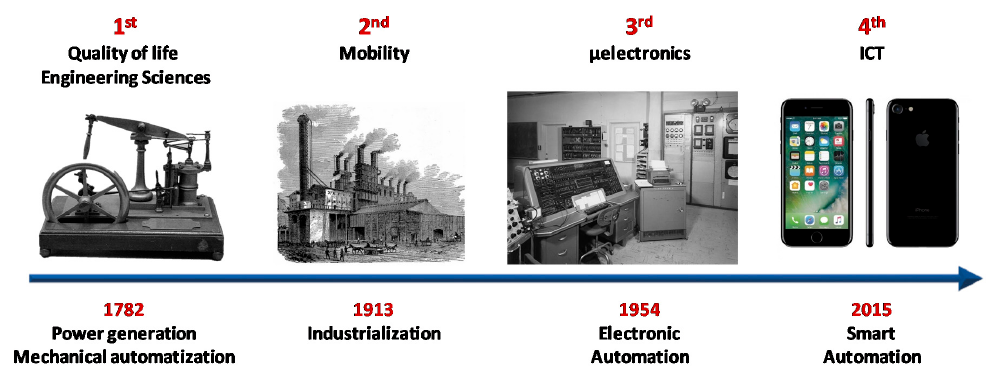
Figure 1. Representation of “Industry 4.0”—the 4th industrial revolution. Adapted from [1]. ICT: information and communication technology.